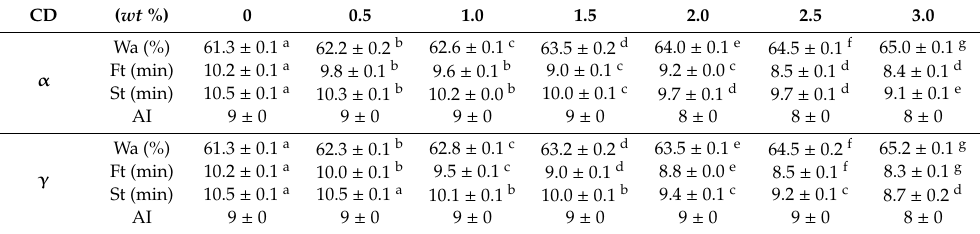
Table 1. E ff ects of di ff erent α -CD and γ -CD contents (0–3.0 wt%) on wheat flour